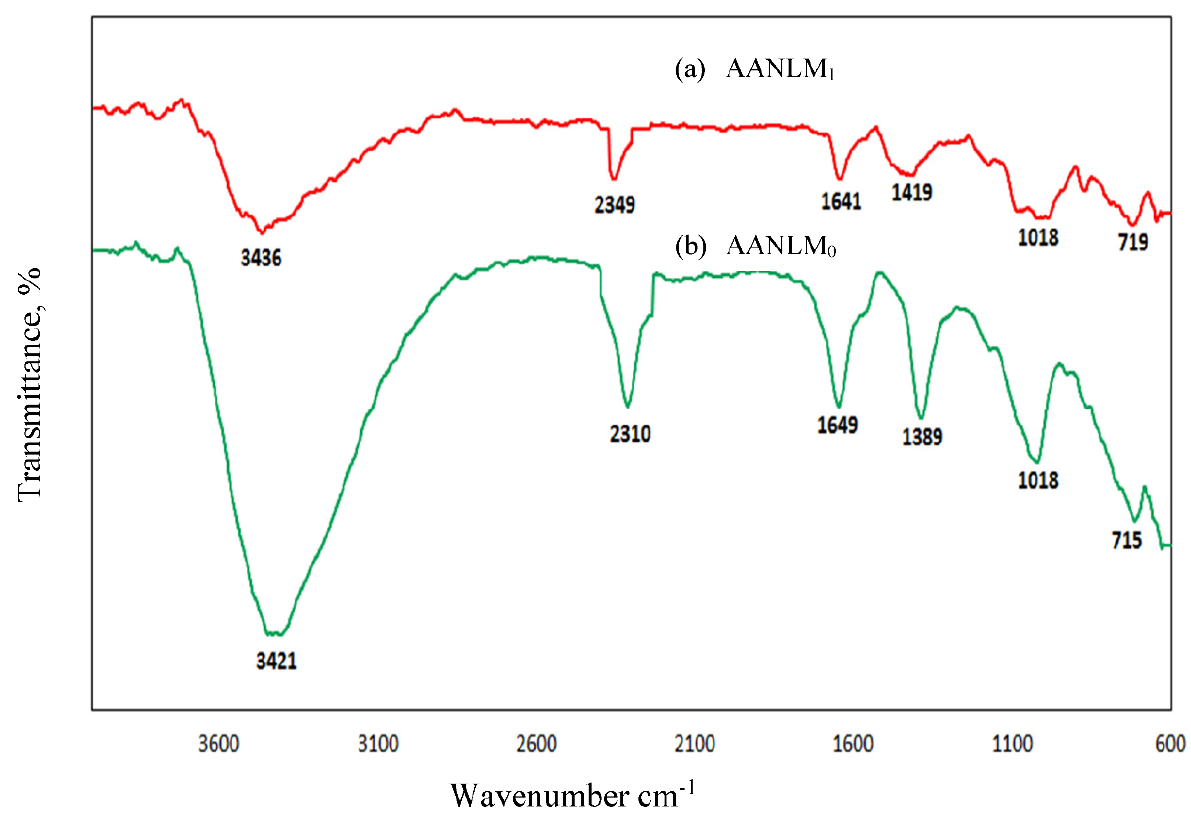
Figure 8. FTIR spectra of binder ( a ) activated using (Ms = 0) and ( b ) (Ms = 0.89).